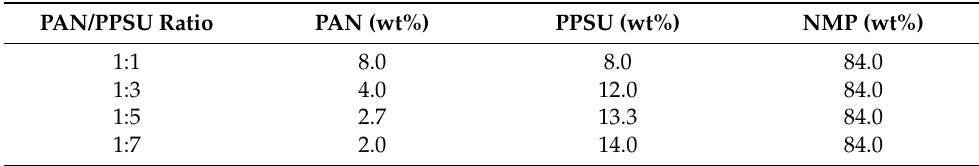
Table 2. Dope formulation for PAN/PPSU substrates